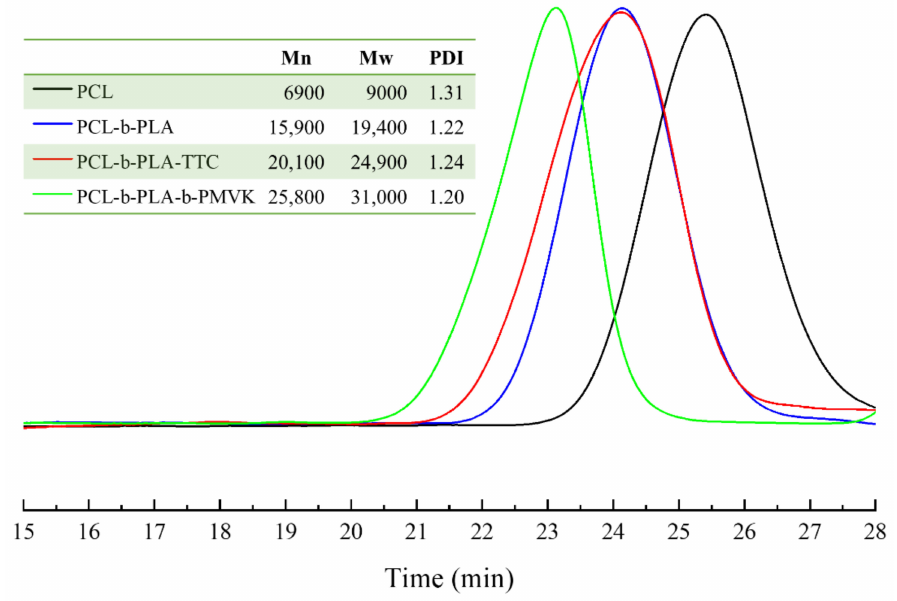
Figure 4. GPC traces of PCL, PCL-b-PLA, PCL-b-PLA-TTC, and PCL-b-PLA-b-PMVK (entry 2 in Table